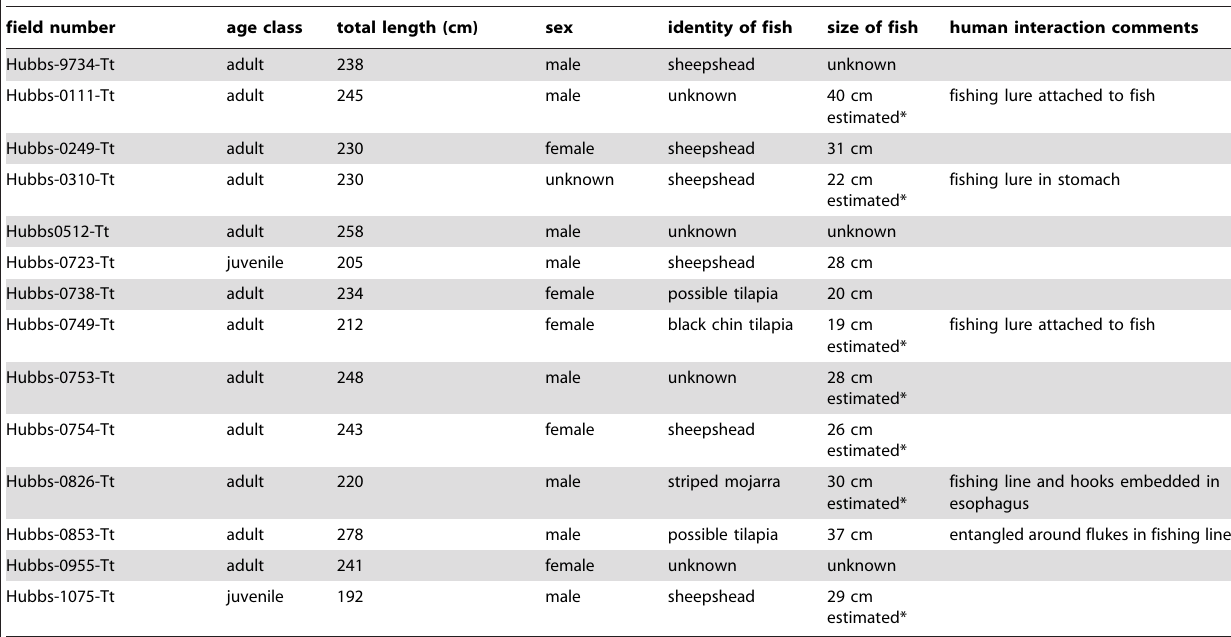
Table 1. Incidence of asphyxiation in IRL bottlenose dolphins